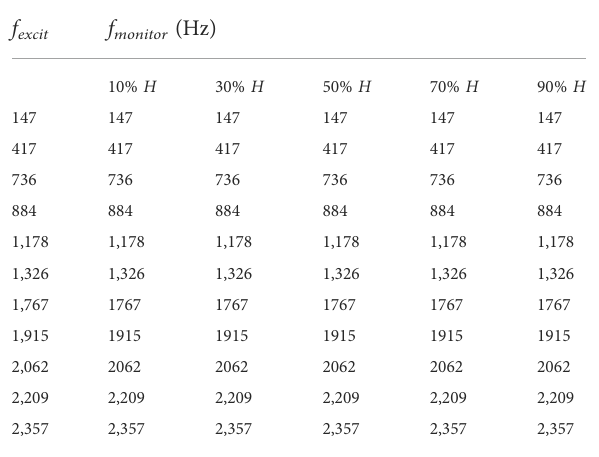
TABLE 3 Spectrum graph of total pressure with different excitation frequencies.